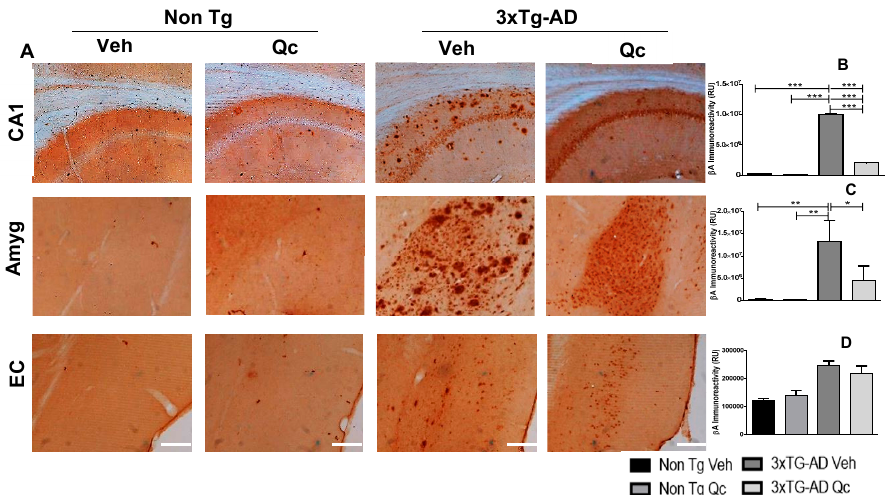
Figure 1. Quercetin oral administration effect on the prevention of β -amyloid plaques in triple transgenic Alzheimer’s disease (3xTg-AD) mice. ( A ) Representative images of β A immunoreactivity in the CA1 region of the hippocampus, the amygdala, and the entorhinal cortex of 19-month-old 3xTg-AD and non-Tg mice treated with vehicle and quercetin. Magnification: 4x. Scale bar: 50 µ m. The values in the immunoreactivity graphs are expressed in relative densitometric units (RU) in CA1 of the hippocampus ( B ) Amyg: amygdala ( C ) and EC: entorhinal cortex ( D ). Veh: vehicle (DMSO 0.5%). n = 3. * p : < 0.05, ** p : < 0.001, *** p : <